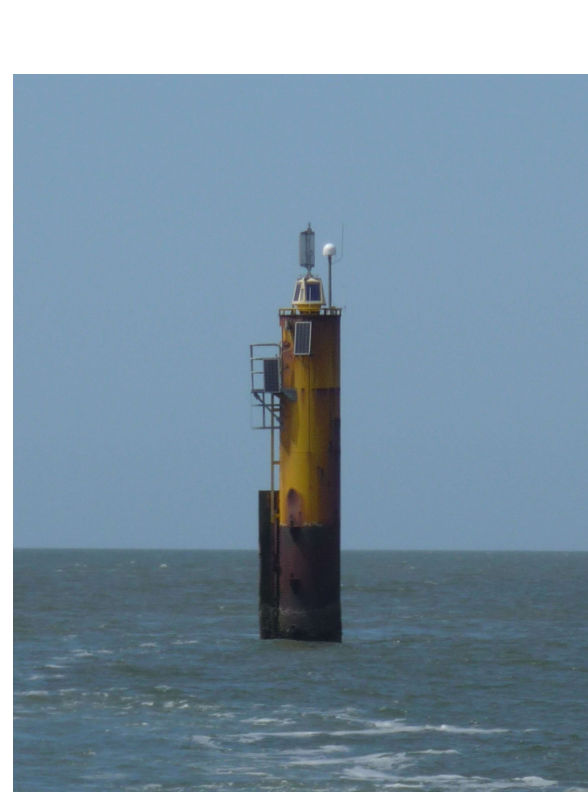
Figure 8: GNSS antenna on top of the pole of the tide gauge station.